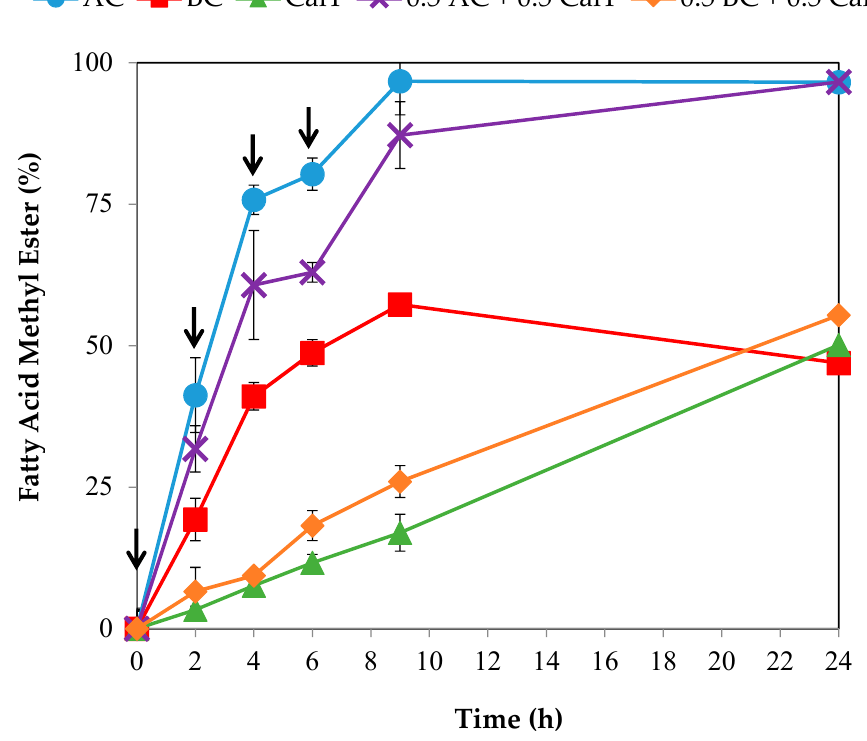
Figure 2. Fatty acid methyl ester (FAME) production by lipase enzymes. AC: lipase produced from recombinant A. oryzae after nanofiltration (NF) concentration; BC: lipase produced from recombinant A. oryzae before NF concentration; CalT: lipase from Thermomyces lanuginosus showing lipase activity similar to AC (diluted around 245-fold); 0.5 AC + 0.5 CalT: half AC and half CalT; and 0.5 BC +